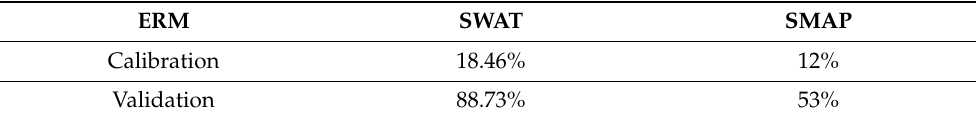
Table 7. ERM of SWAT and SMAP simulations.